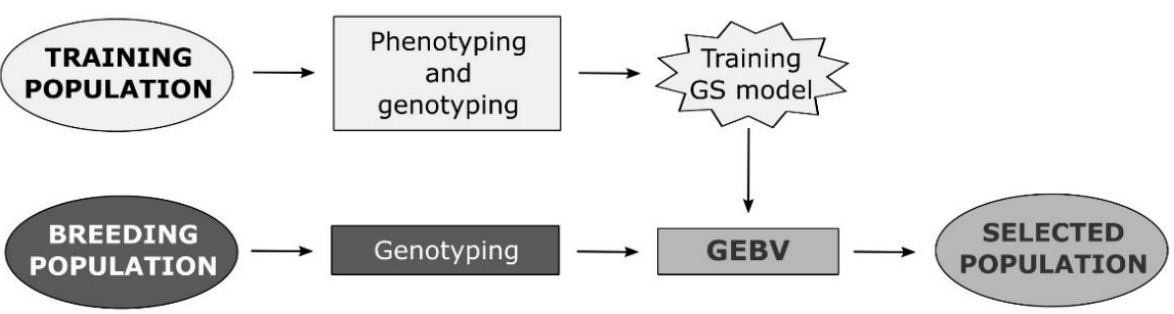
Figure 1. Flow diagram of a plant breeding program based on genomic selection. High-throughput genotyping generates a large amount of marker data, which are then used in GS. When the number of predictor variables (markers) is much greater than the number of observations (phenotypic values), the result is an infinite number of marker effect estimates. In order to reduce the problem of highly dimensioned data, different parametric and nonparametric models have been developed and used in GS (Figure